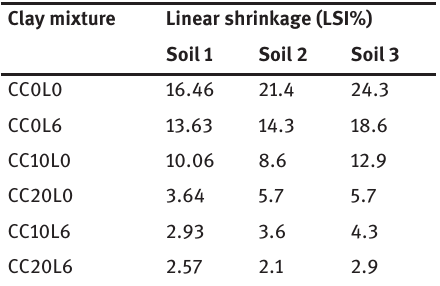
Figure 8. Photograph of soil S3 (some untreated and treated samples).